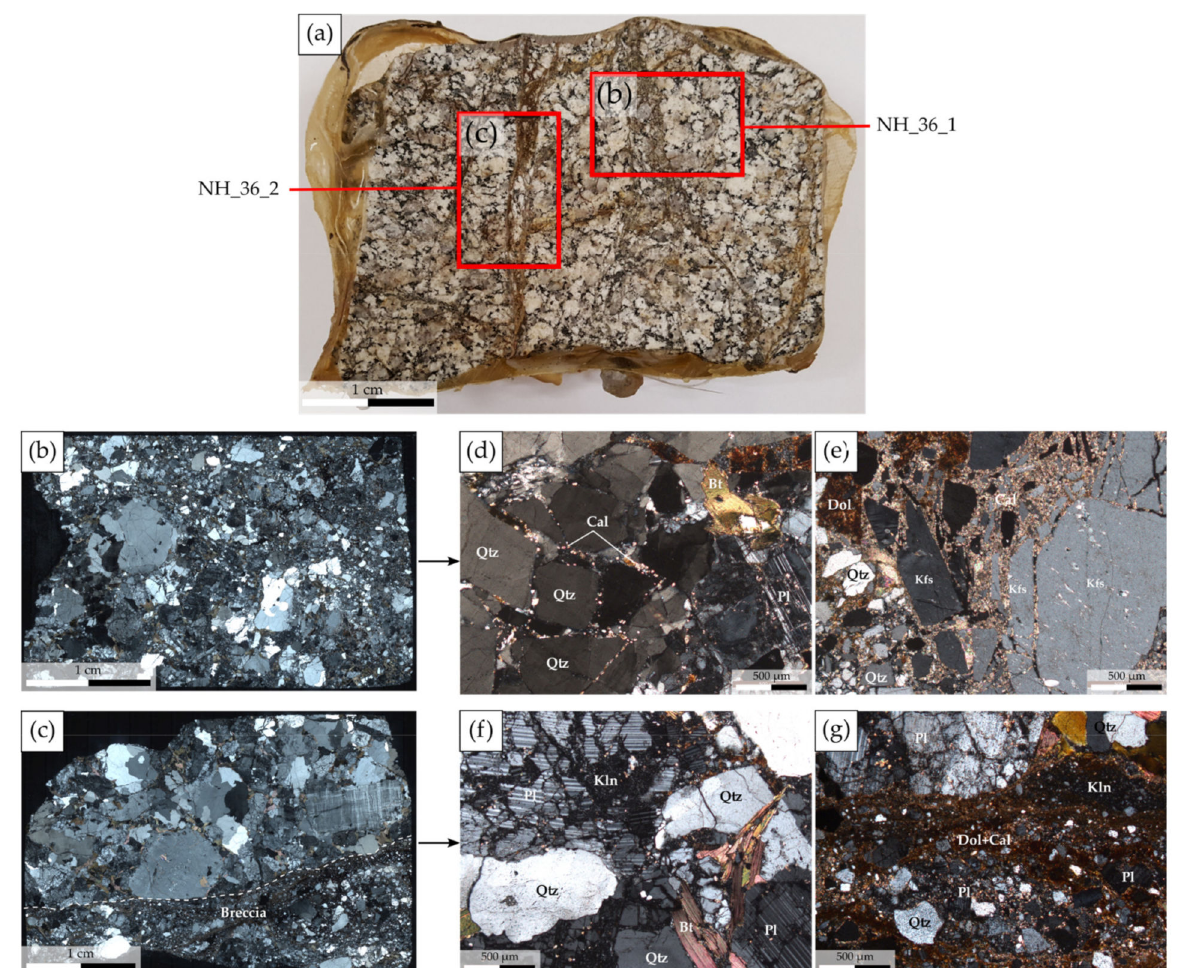
Figure 11. ( a ) Sample NH_36 collected close to a fault zone showing the location of the two thin sections. ( b ) A mosaic of the thin section NH_36_1 showing a breccia. ( c ) A mosaic of the thin section NH_36_2 showing the limit between a breccia and the almost preserved granite. ( d ) A microphotograph of the NH_36_1 thin section showing a brecciated and slightly altered plagioclase, a brecciated quartz with a significant undulatory extinction, starting to recrystallize into subgrains, a brecciated biotite, and calcite crystallizing in the microfractures. ( e ) A micrograph of thin section NH_36_1 showing brecciated and non-altered K-feldspar and quartz with dolomite and calcite deposits between the clasts. ( f ) A microphotograph zooming in the preserved granitic zone visible of the thin section NH_36_2 and showing a brecciated and partially replaced plagioclase into kaolinite and brecciated, but unaltered, quartz and biotite. ( g ) A microphotograph zooming in the brecciated part of the thin section NH_36_2 and showing a carbonate matrix composed of dolomite and calcite transported clasts from the